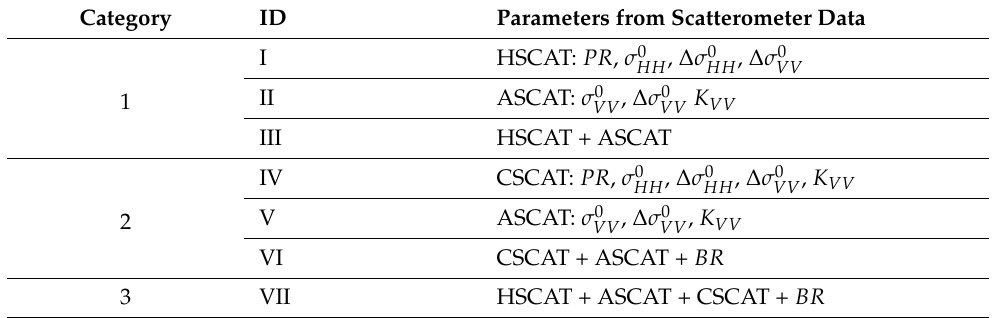
Table 3. Categories of SVM model experiments.